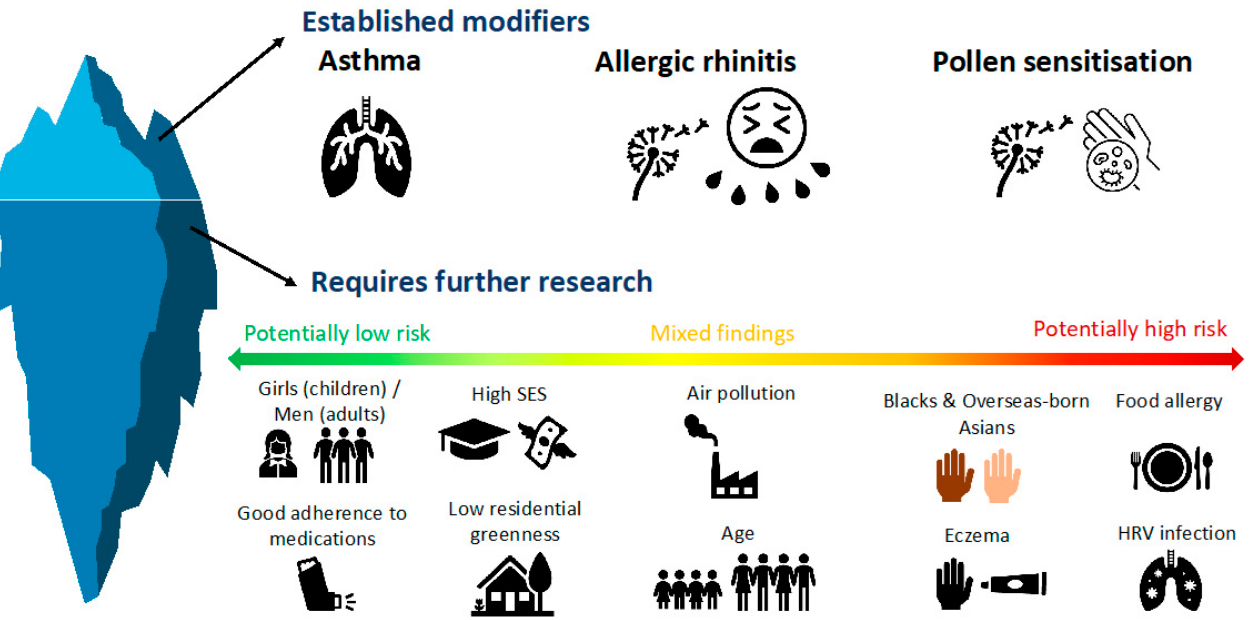
Figure 2. Current evidence of potential effect modifiers of the associations between short-term ambient pollen exposure and respiratory outcomes.